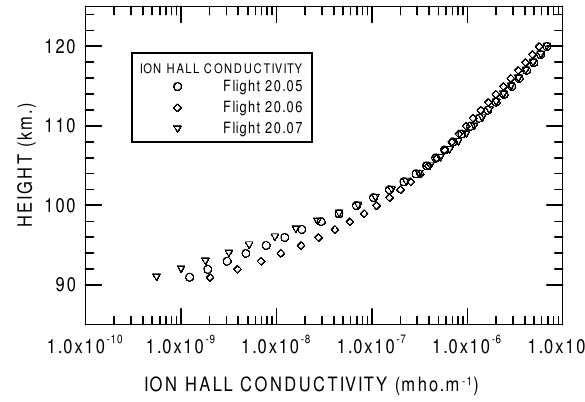
Fig. 4. Height profile of the magnitude of the ion Hall conductivity σ Hi estimated for the three cases represented in Figs. 1 to 3 for the rocket flights 20.05, 20.06 and 20.07,